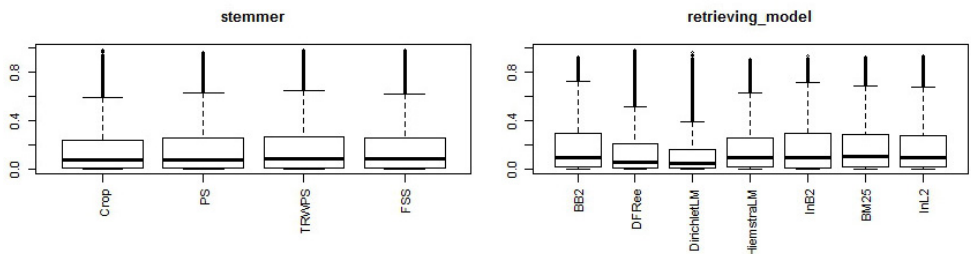
Figure 11. The choice of the weighting model has more impact than the stemmer used. Individual boxplots represent average precision on the TREC 7 and 8 topics when a given component is used in a query processing chain—80,000 query processing chains or component combinations were used. Figure reprinted with permission from [7], Copyright 2015,